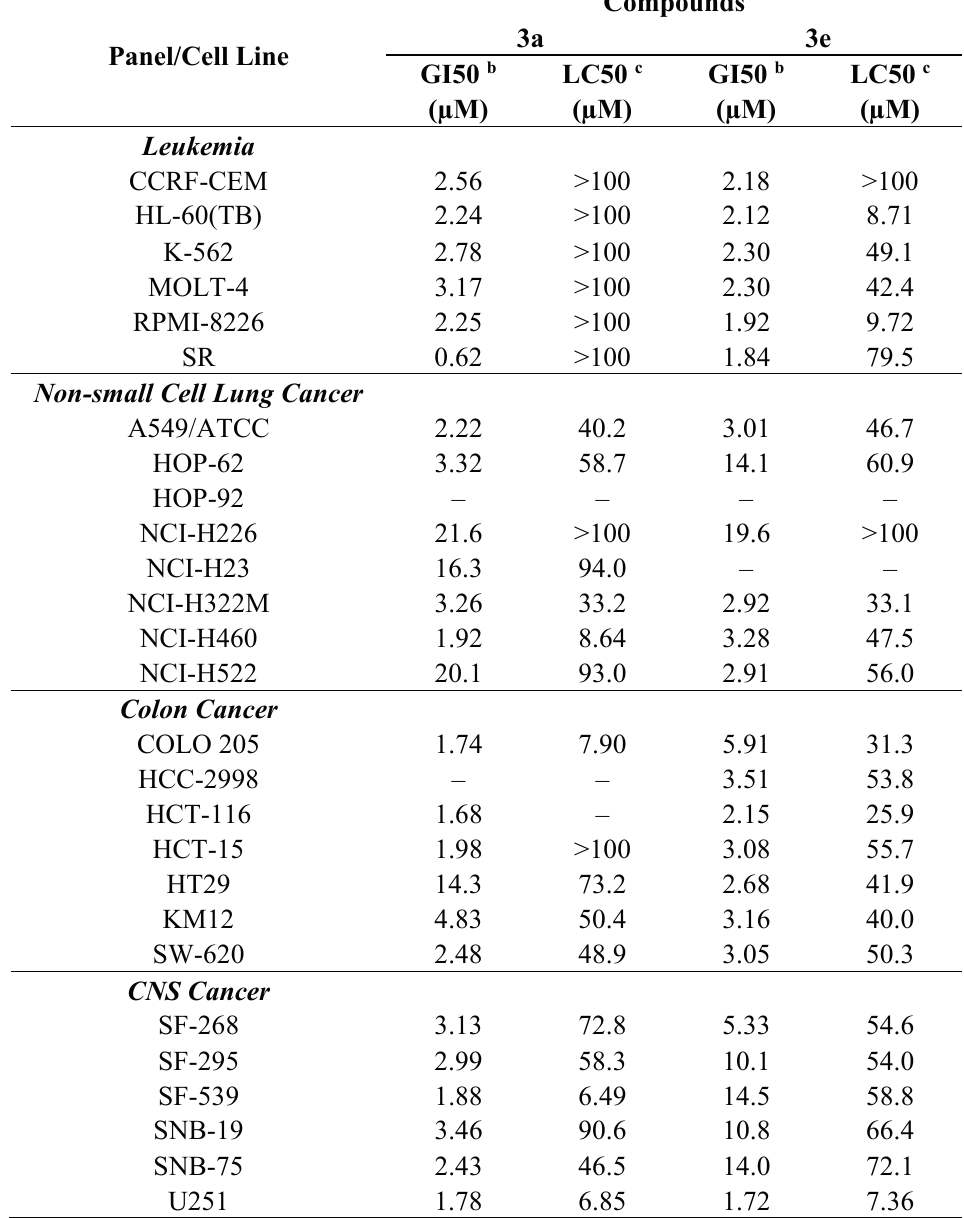
Table 6. In vitro testing expressed as growth inhibition of cancer cell lines for compounds 3a and 3e a